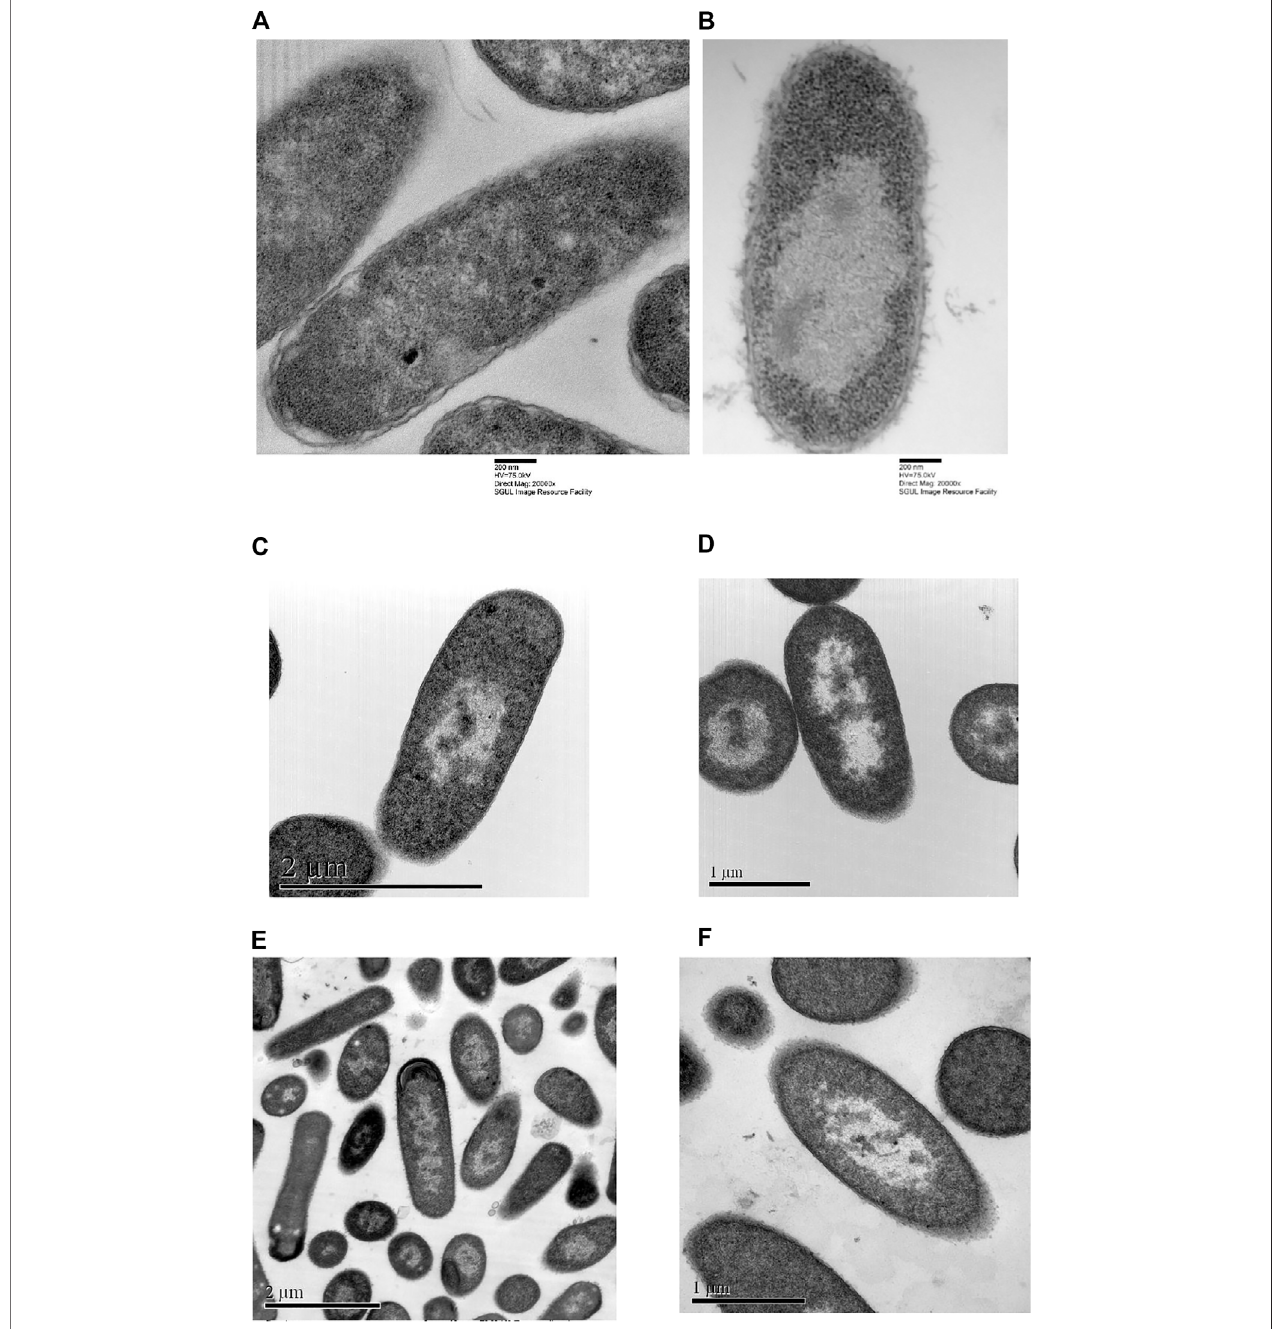
FIGURE6 | Transmissionelectron micrographs of Escherichia coli . (A) Untreated samples, (B) treated with optP7 for 60 min, at 32 μ g/ml, (C) and (D) treated with chloramphenicol for 240 min, 60 μ g/ml, (E) and (F) treated with tetracycline for 240 min, 30 μ g/ml.